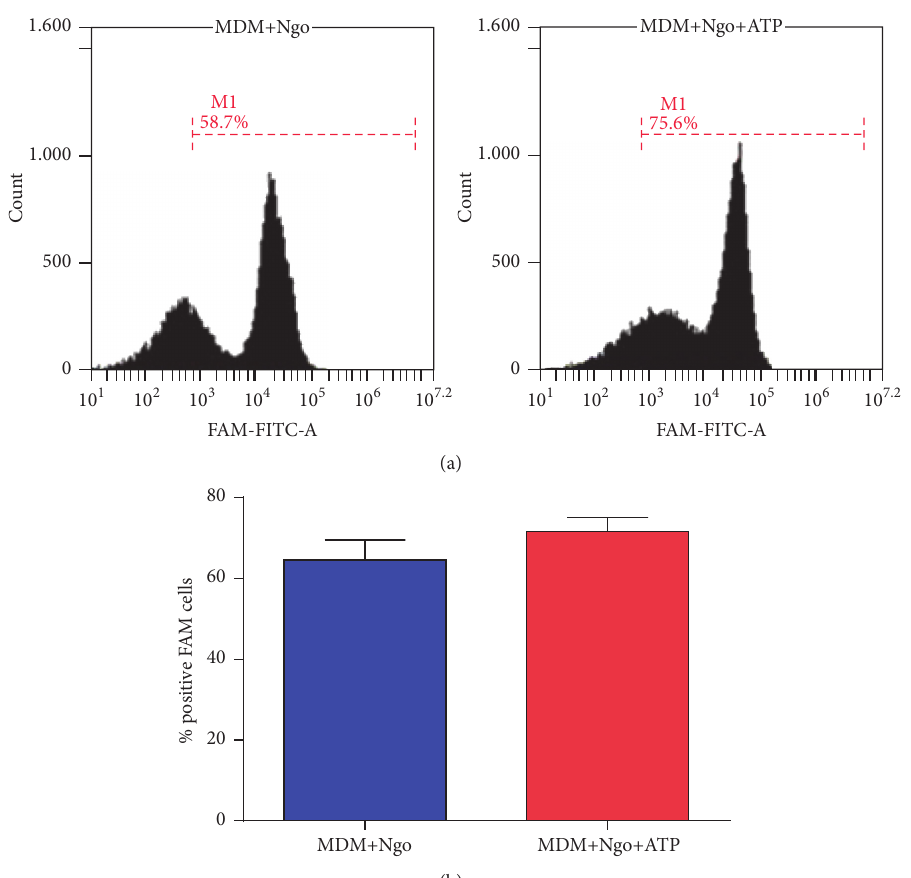
Figure 3: ATP treatment does not modify caspase-1 activity in Ngo-infected MDM. The fluorescent labeled probe of caspase-1 FAM-YVAD- FMK (FAM-FITC) was incubated with uninfected MDM, gonococcus-infected MDM (Ngo+MDM), or gonococcus-infected MDM and ATP (Ngo+MDM+ATP). After washing, the fluorescent intensity retained by the MDM was determined by flow cytometry. (a) Representative histograms from one assay are shown. (b) Percentage of positive FAM cells under different conditions. Data obtained are expressed as the mean ± SD and represent at least three independent